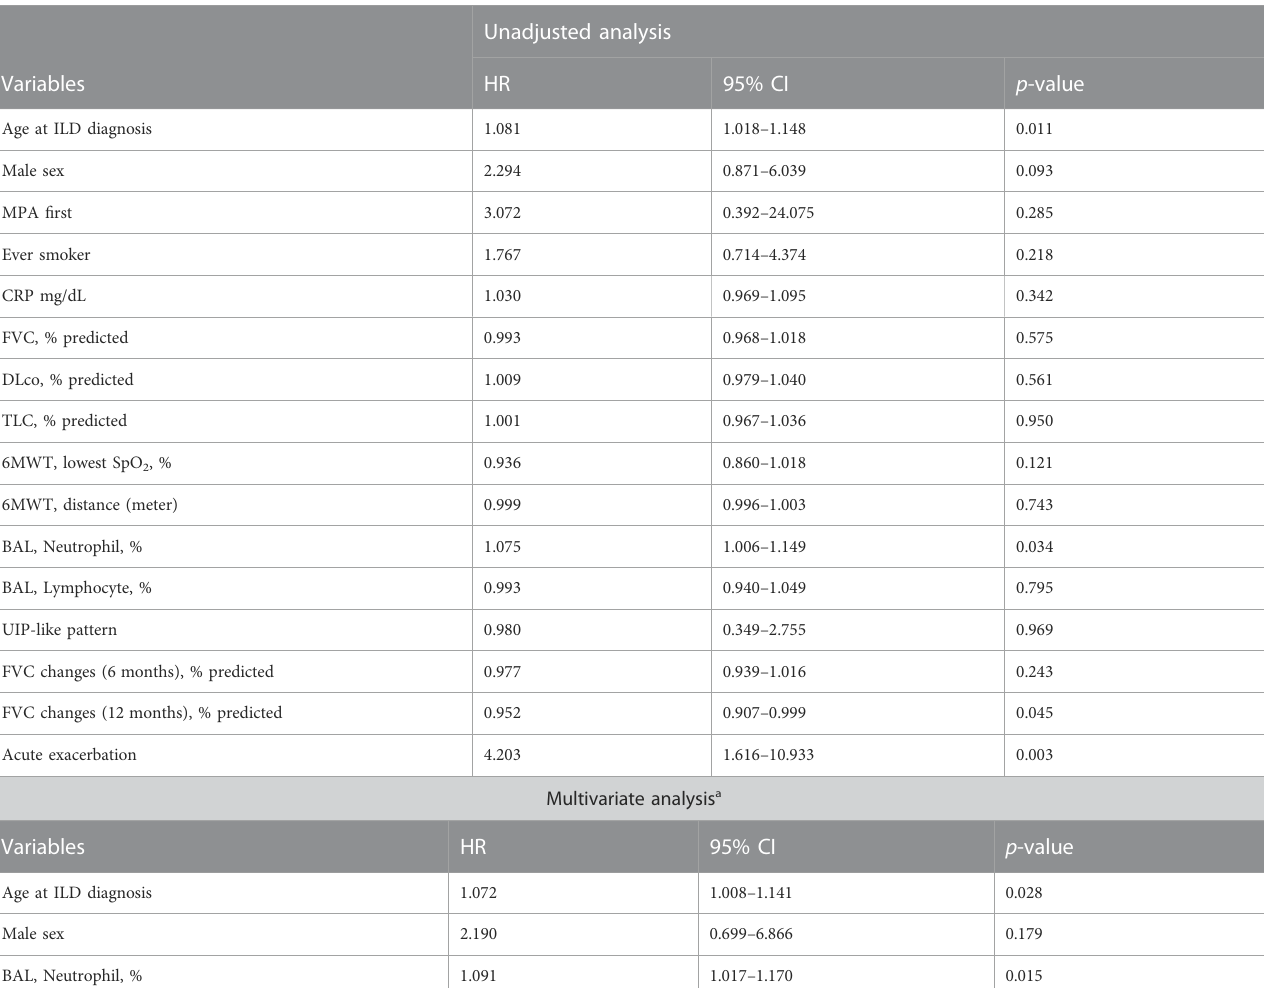
TABLE 5 Prognostic factors for mortality in patients with MPA-ILD assessed by Cox regression analysis. Unadjusted